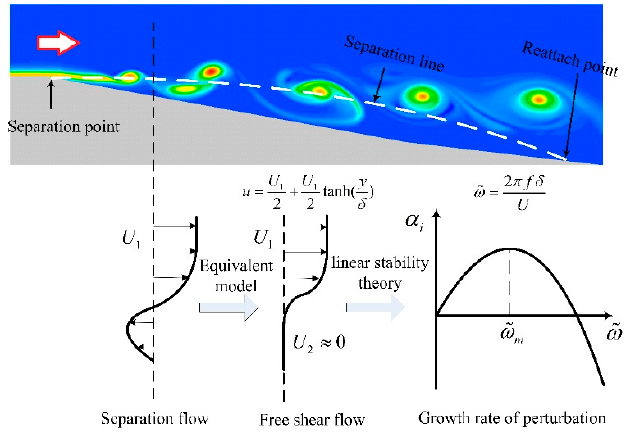
Figure 12. Relationship between flow separations and free shear layers based on linear stability theory.